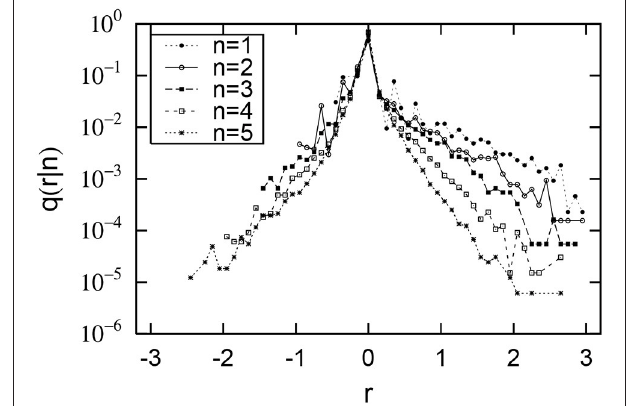
FIGURE 1 | Distributions of sales growth rate of Japanese firms. The horizontal axis shows the logarithmic growth rate: r = log 10 x 2014